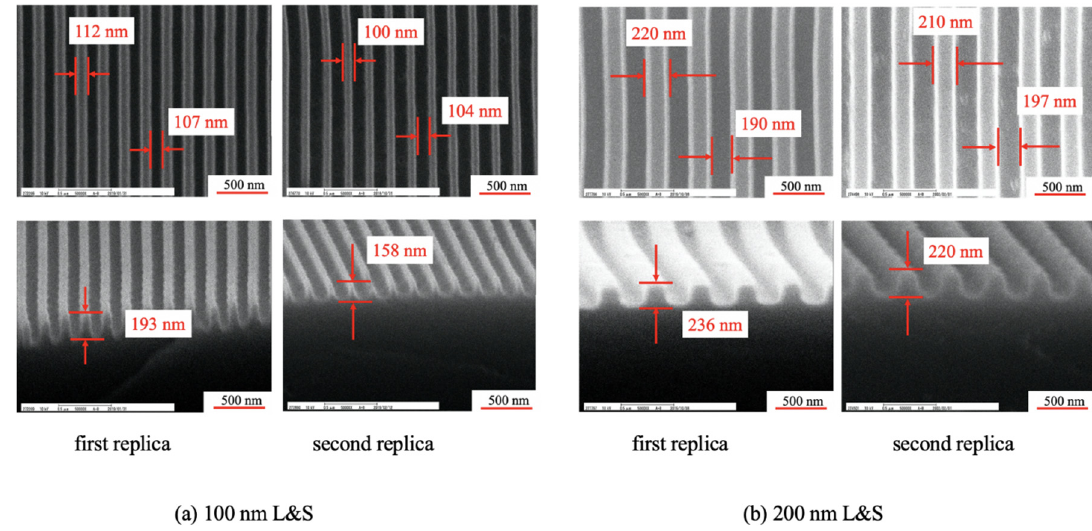
Figure 2. Scanning electron microscopy (SEM) images of the first and second replica molds for the transferred patterns of the ( a ) 100 nm line-and-space (L&S) and ( b ) 200 nm L&S transferred patterns.